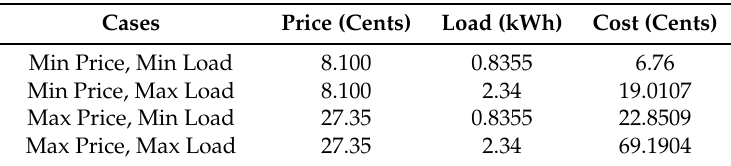
Table 11. Possible cases: OTI 30-min using